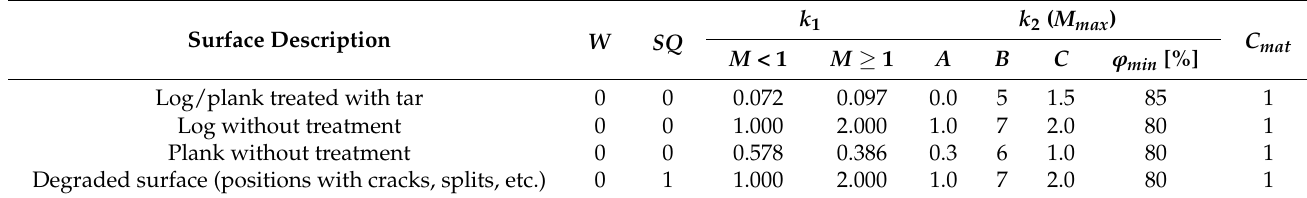
Table 3. Parametrization of the updated VTT mold model based on the features of the examined surfaces.